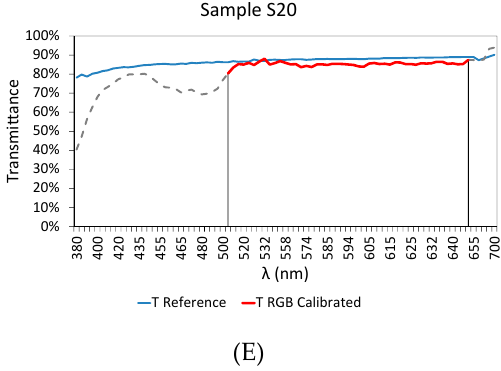
Figure 19. Comparative results of the transmittance values between commercial equipment based on the incandescent lamp (blue) and RGB-LED device developed (red) after the calibration within 510–645 nm, for the following samples used during the calibration process: ( A ) S7, ( B ) S12, ( C ) S15, ( D ) S16, and ( E ) S20.